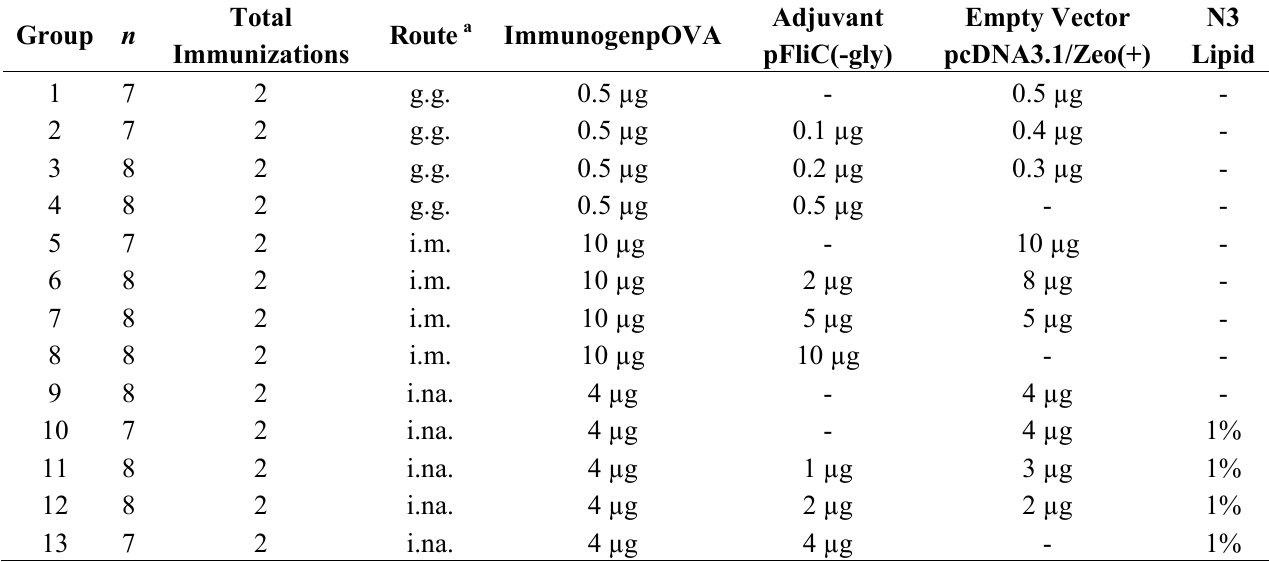
Table 1. Vaccinated groups for ovalbumin (OVA) experiments.